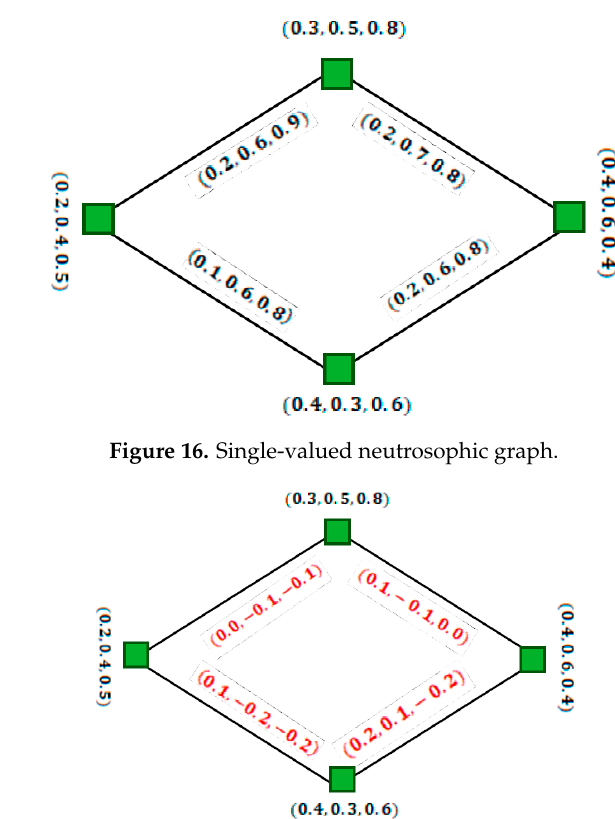
Figure 17. Complement of the SVNG depicted in Figure 16.